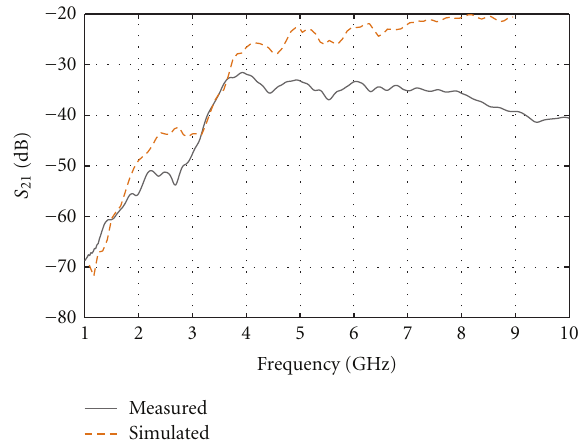
Figure 10: Transmission measurement through a rubber mem- brane containing a 1% saline solution (“high-loss breast model”) and with 2% saline filling the region between the two sensors positioned with the same separation distance